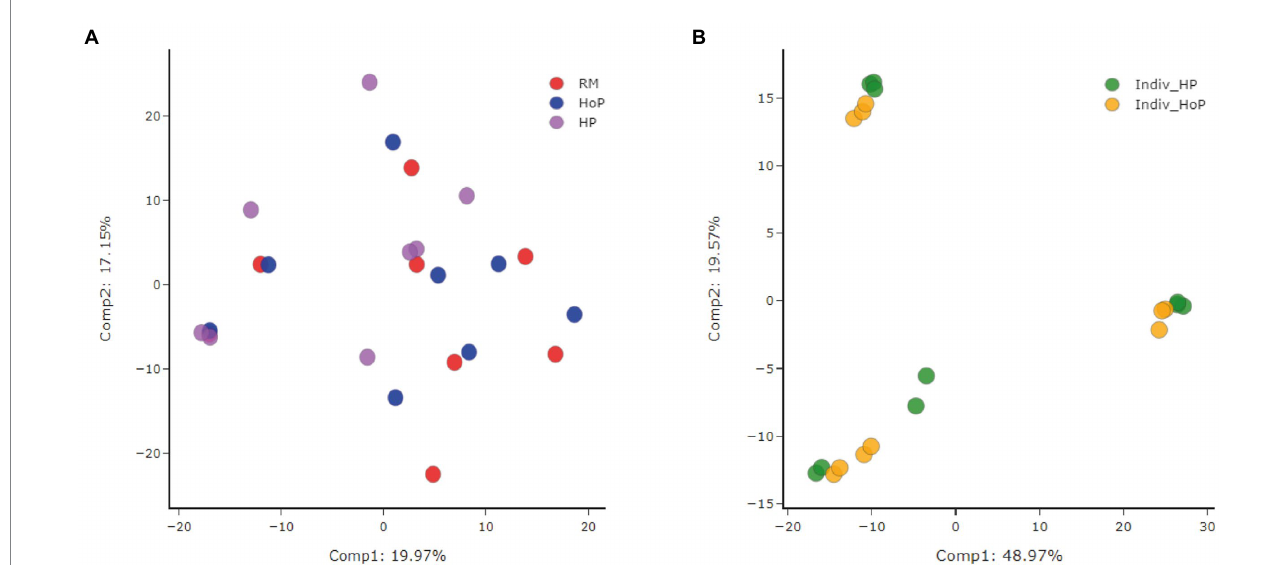
FIGURE 1 Principal component analysis (PCA) of the two cohorts of DM samples used in this study. The first cohort (A) consisted of pooled DM samples ( n = 8/group) stratified according to treatments [raw milk (RM), HoP-treated milk (HoP) and HP-treated milk (HP)]. No separation of the raw milk, HoP, or HP samples was observed in this first cohort. The second cohort (B) consisted of individual DM samples from 10 donors that were treated individually by either method of sterilization (Indiv_HoP and Indiv_HP). A separation between groups was observed for subsets with 3 clusters of samples in this second